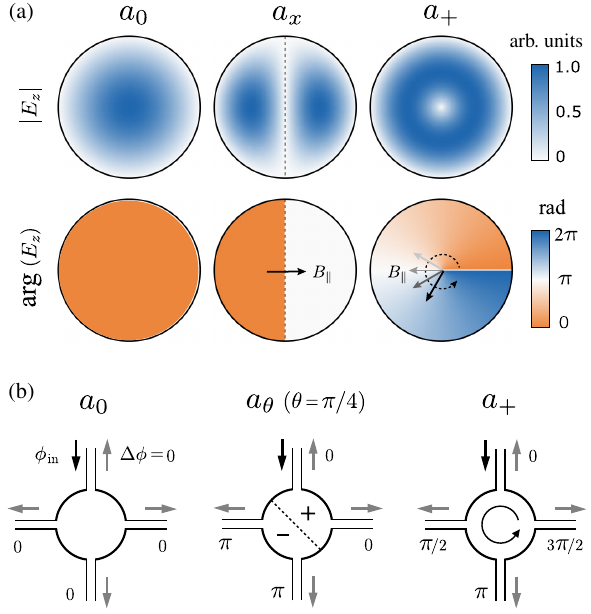
FIG. 1. (a) Structure of the electric field amplitude and phase (with corresponding magnetic field polarization) of the modes being considered. The fundamental mode has uniform phase everywhere, with no nodes in the sole electric field component E . The twofold degenerate first excited manifold may be z spanned by two modes with geometrically orthogonal linear nodes in the E field ( a and a ), or, equivalently, by two modes z x y exhibiting a single point node and (cid:2) 2 π phase winding around the periphery ( a , the polarization of the Þ . For the modes a x and a (cid:2) þ magnetic field at the cavity center is presented. The polarization of the magnetic field points along the gradient of the phase of E . z For linear modes, the magnetic field is oriented perpendicular to the nodal line, with direction oscillating in time. For the chiral modes, this magnetic field polarization precesses in time with frequency ω 0 . The size of the circles does not reflect the physical dimension of the cavities, which is chosen such that the desired mode is always at frequency ω 0 . (b) The geometric phase acquired, for a photon of frequency ω 0 , when tunneling through a cavity in which each type of mode has been isolated. Left: A fundamental mode cavity will induce no tunneling phase shift between any two contacts. Center: An isolated linear mode (via a diagonal conductor or dielectric) will induce a tunneling phase shift of either 0 or π . Right: An isolated circular mode (via a ferrite in a magnetic field) will produce a phase shift equal to the relative angle between the incoming and outgoing tunnel